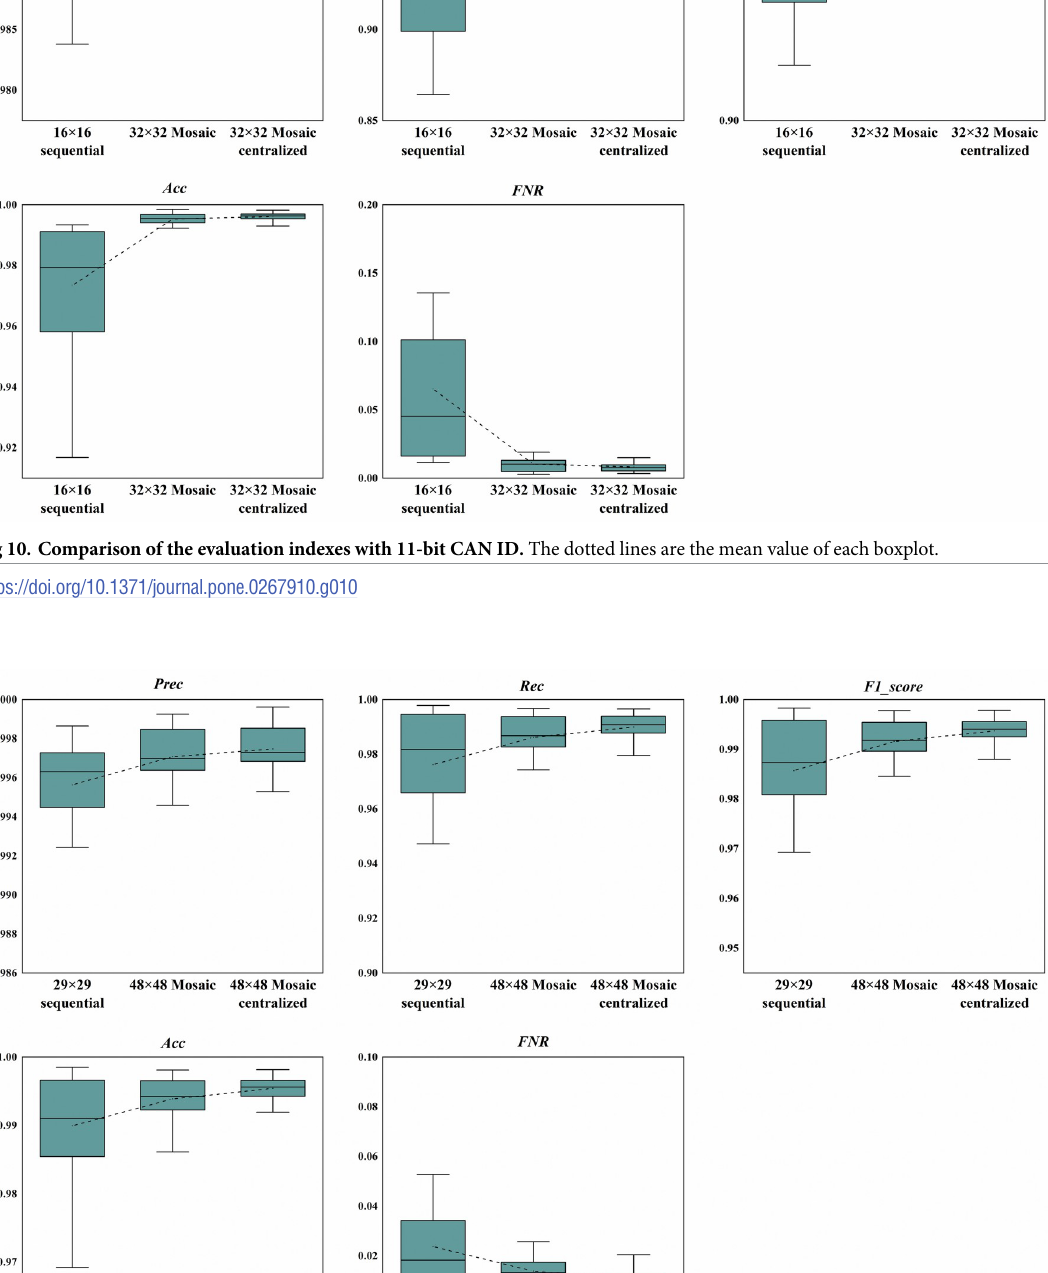
PLOS ONE | https://doi.org/10.1371/journal.pone.0267910 May 5, 2022 15 /